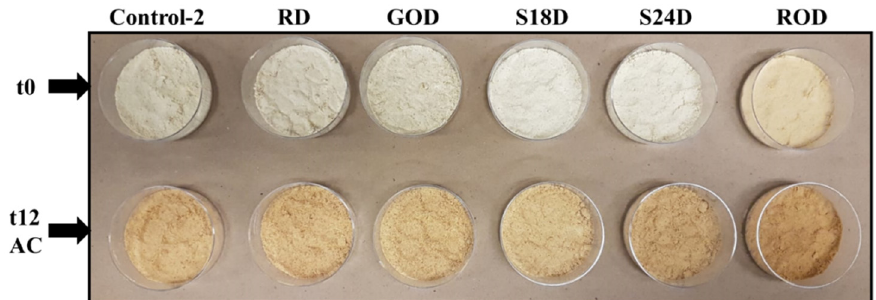
Figure 5. Change in color of FFSF samples kept under AC for 12-weeks (t12) compared to day zero (t0).